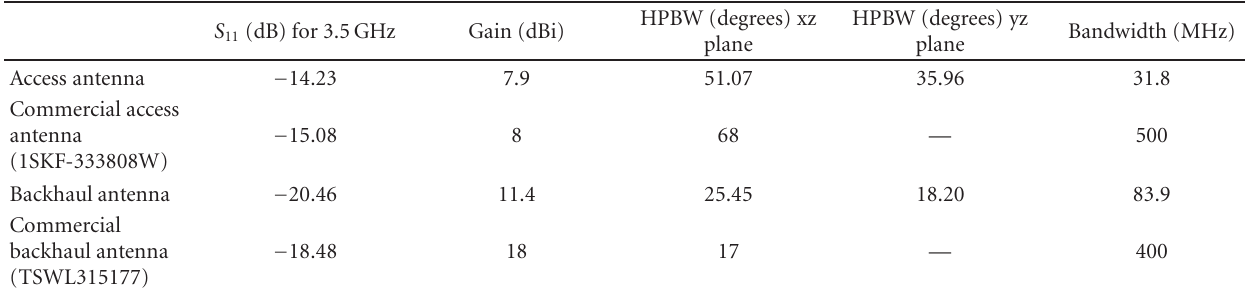
Table 1: Access and backhaul antenna